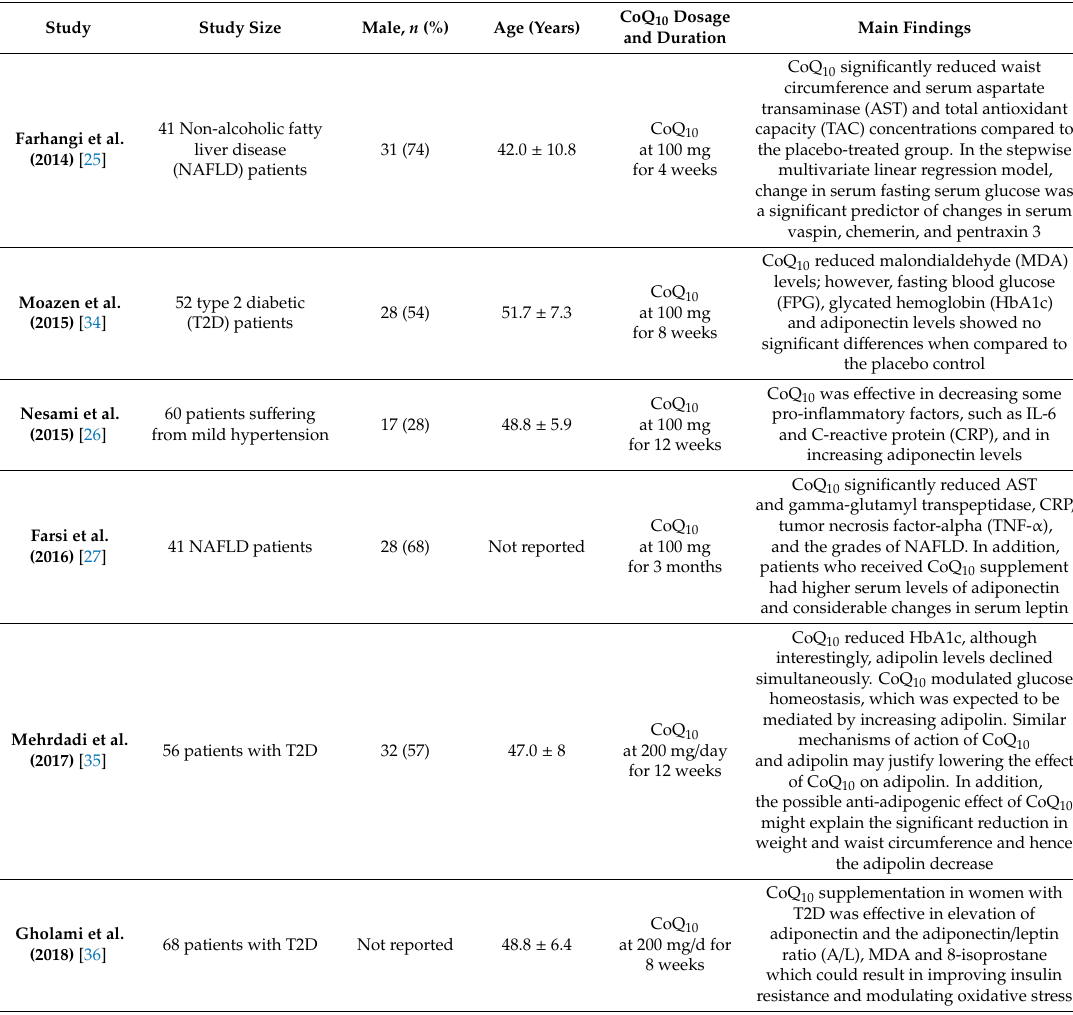
Table 1. Characteristic features of included studies and the reported impact of coenzyme Q 10 (CoQ 10 ) on adipokine function and inflammatory